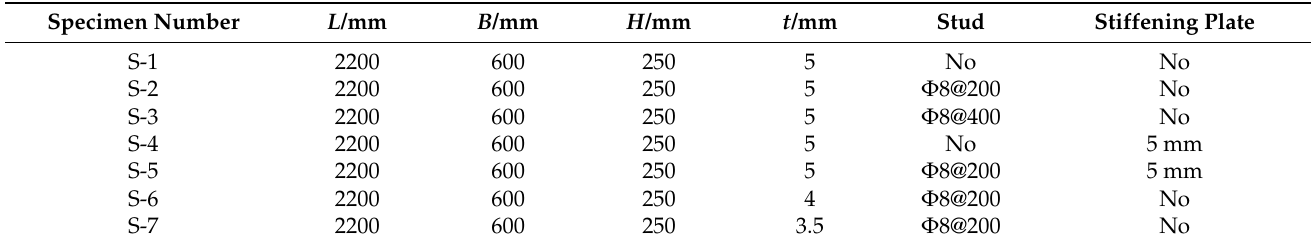
Table 1. The main parameters of the seven specimens.